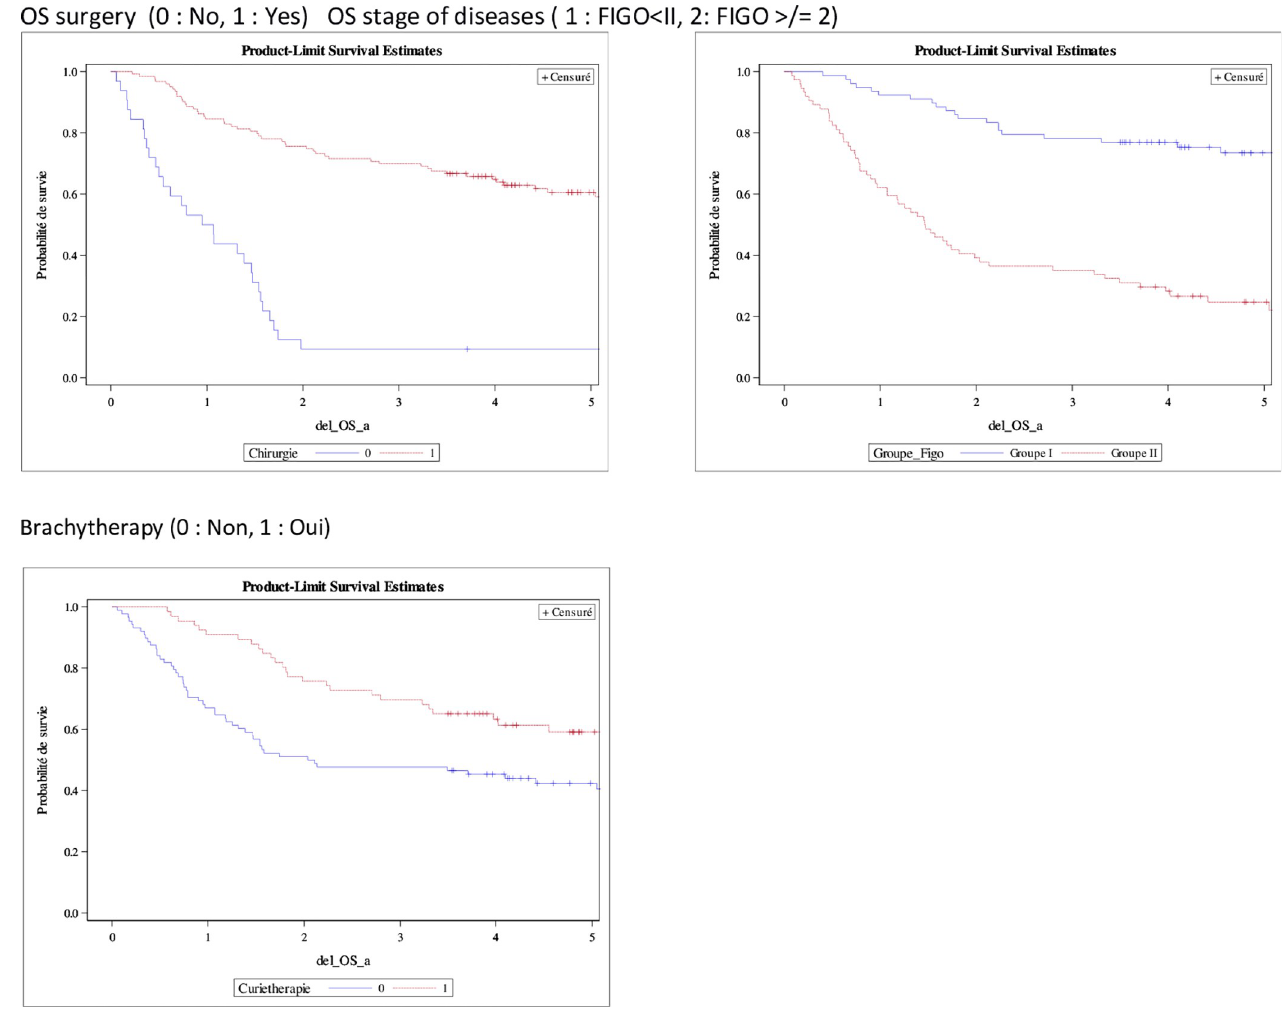
Fig 3. Multivariate prognostic: Risk factors of endometrial cancer survival in Martinique. Multivariate analysis.